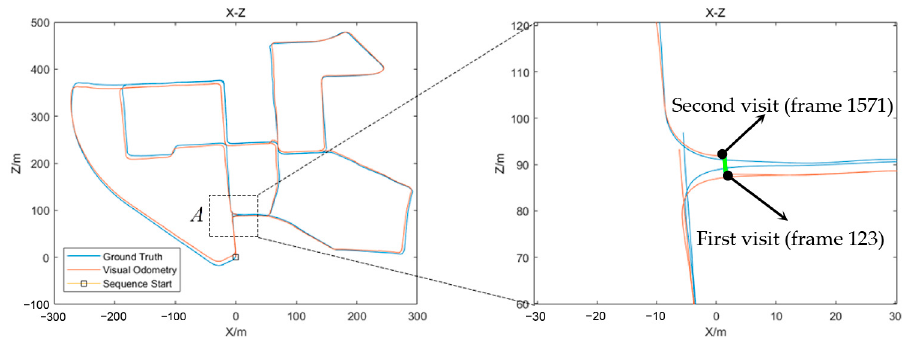
Figure 5. VCM on sequence 00. The green line indicates the drift error correction of frame 1571 where the vehicle revisits corner A .